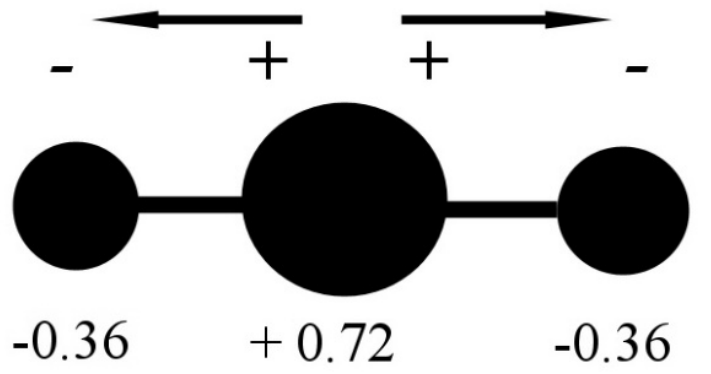
Figure 2. CO 2 molecule charge separation with negative partial charge ( − 0.36 electron unit) on the Oxygen atoms and positive partial charge (+0.72 electron unit) on the Carbon atom. Data from [3]. Carbon dioxide behaves, in general, as a Lewis acid/base by binding the nucleophiles to the Carbon atom and the electrophiles to the two Oxygen atoms [25]. In self coordination, the acid/base Lewis mechanism should result in the interaction between a lone pair of O of one CO 2 molecule to the electron deficiency of C of the second CO 2 molecule (Figure 3). In water coordination, the CO 2 Lewis acid/base behaviour results in an interaction between a lone pair of the O atom of a H 2 O molecule and the lacking lone pair of the C atom of a CO 2 molecule. Computational chemistry methods could give a useful framework on intermolecular interactions and resulting geometry, both in CO 2 coordination chemistry, as in the case of CO 2 -H 2 O and in self-aggregation of the pure